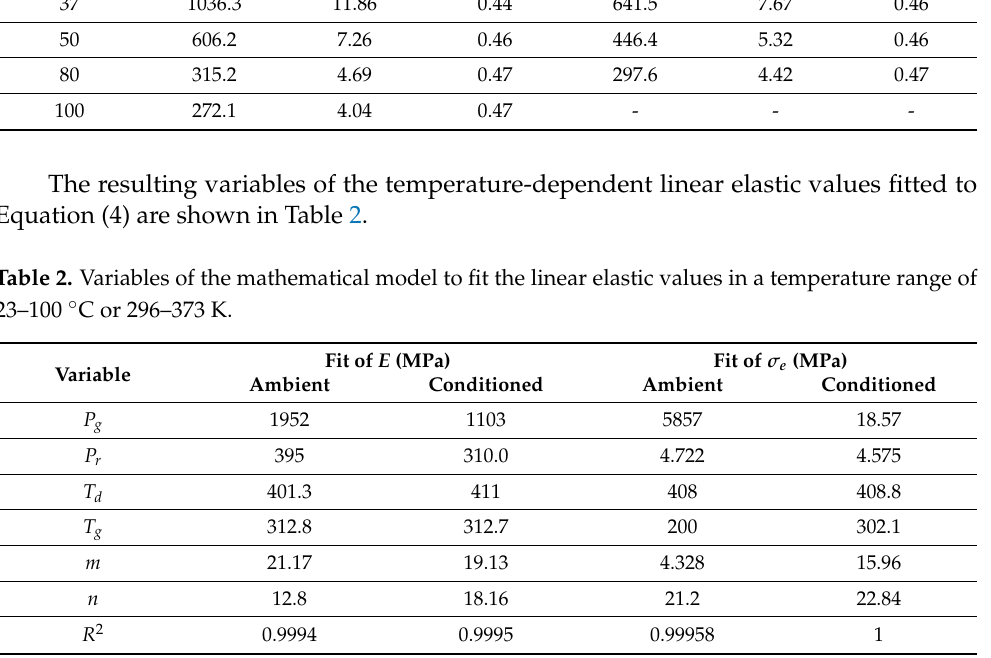
Table 1. Linear elastic values. 𝐸 and 𝜈 were taken from [18]. 𝜎 (cid:3032) represents the first value of the HC.